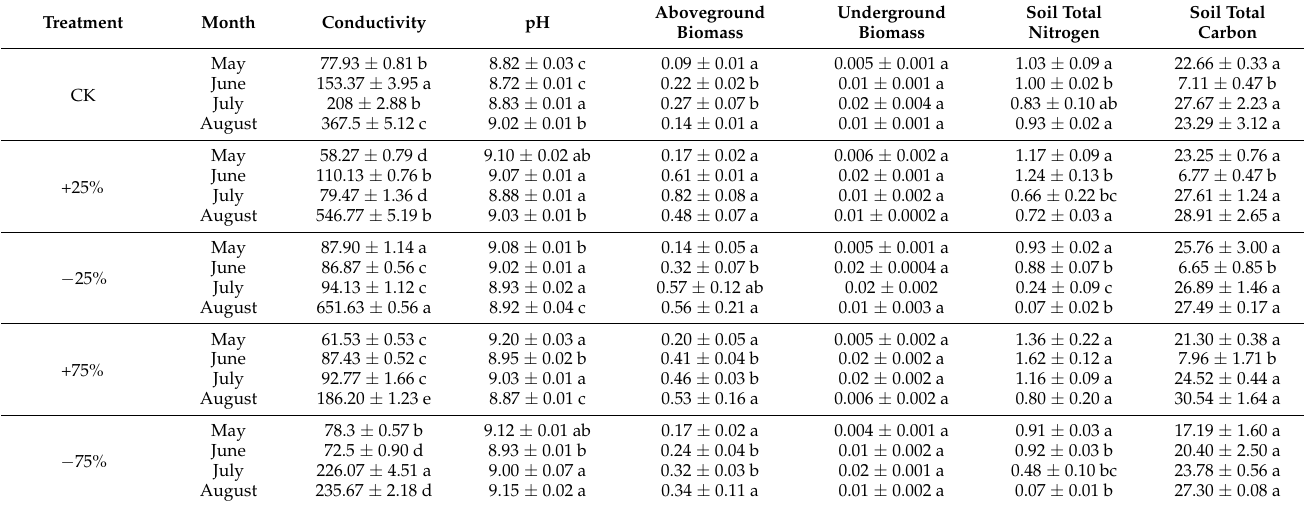
Table 3. Physical and chemical properties of the surface soil under different rainfall treatments during the growing